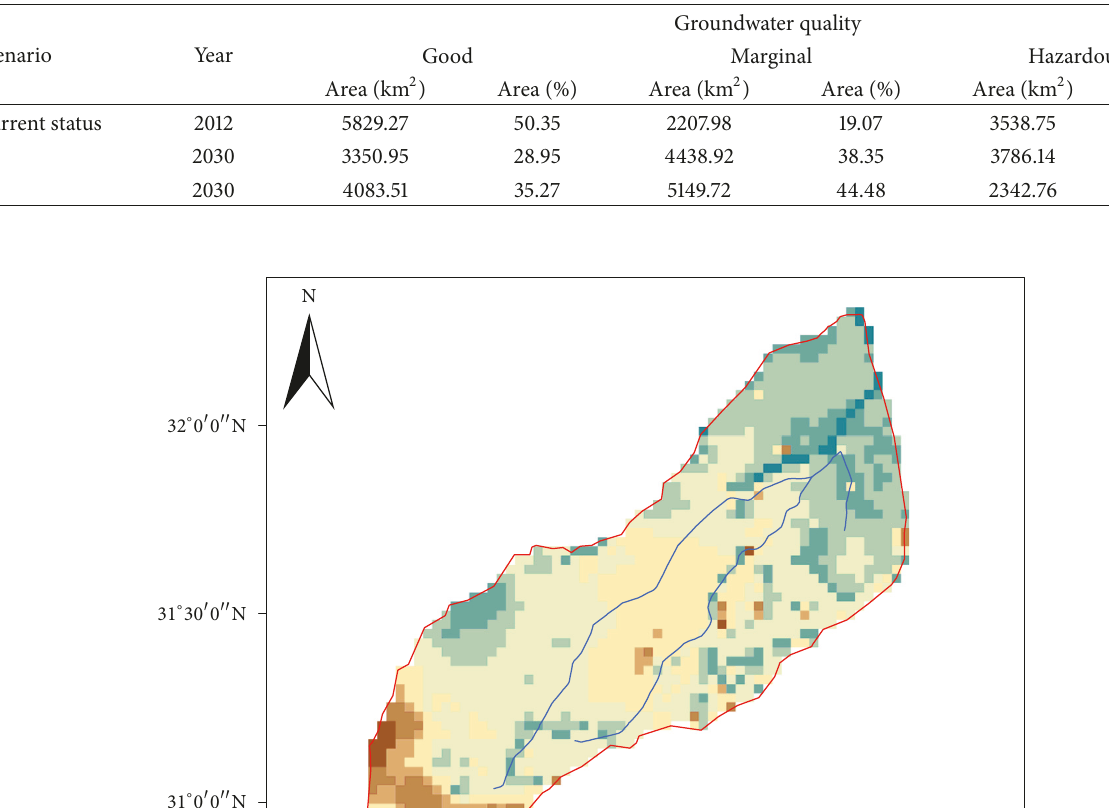
Table 5: Summary of groundwater TDS under Scenarios I and II.